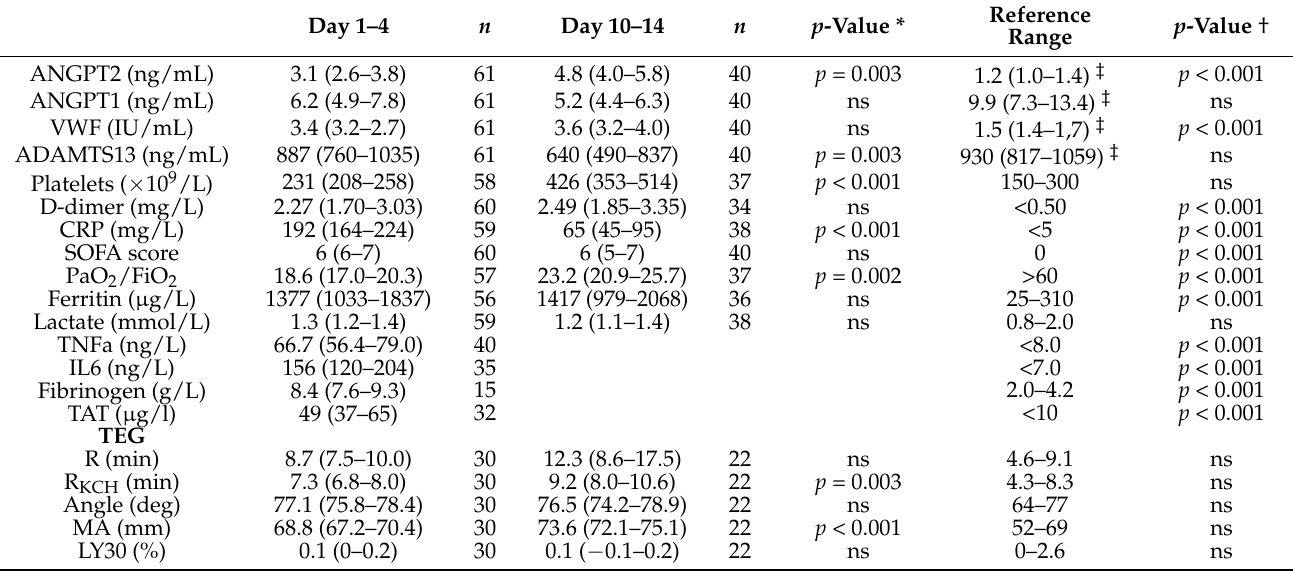
Table 3. Clinical parameters of patients during ICU